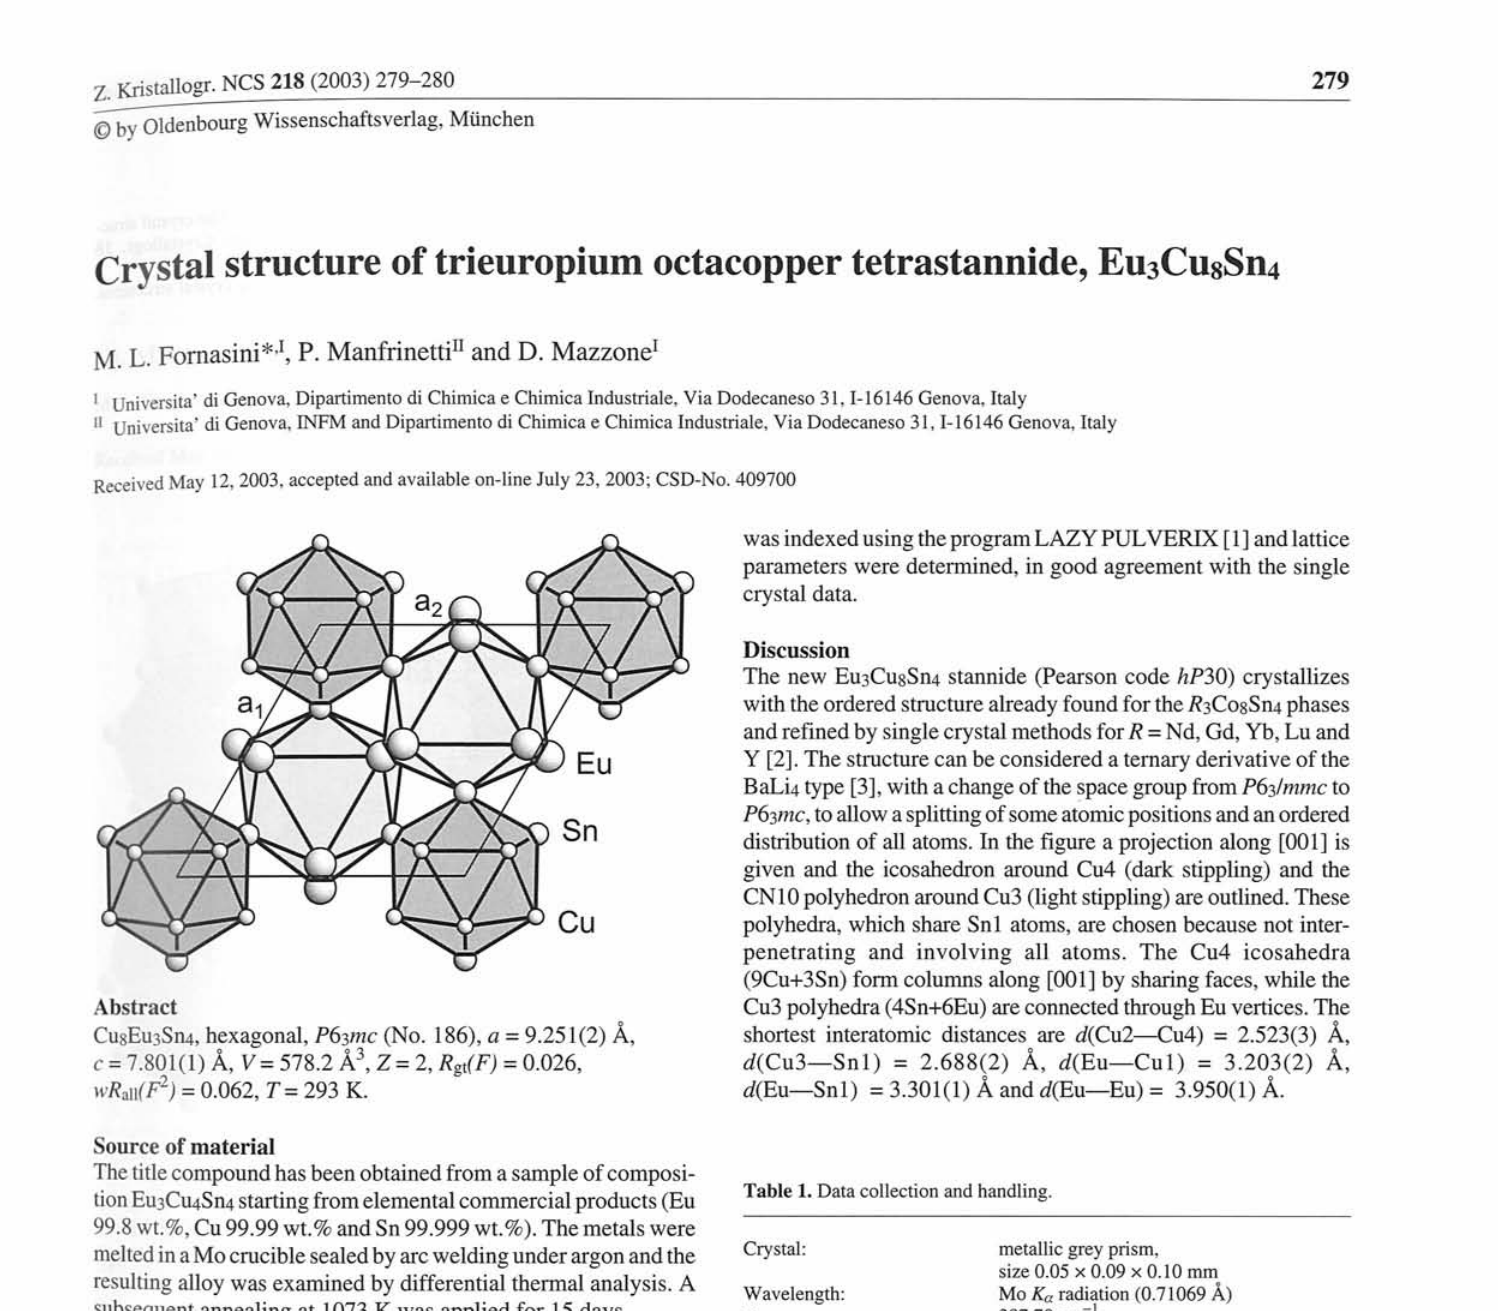
Table 2. Atomic coordinates and displacement parameters (in A 2